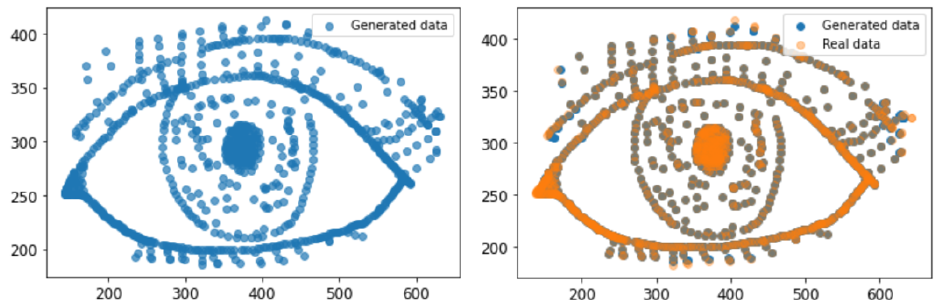
Figure 16. The eye generated by the WGAN ( left ) and the comparison between the real data and the generated data ( right ) using the constrained input method described in Algorithm 1.